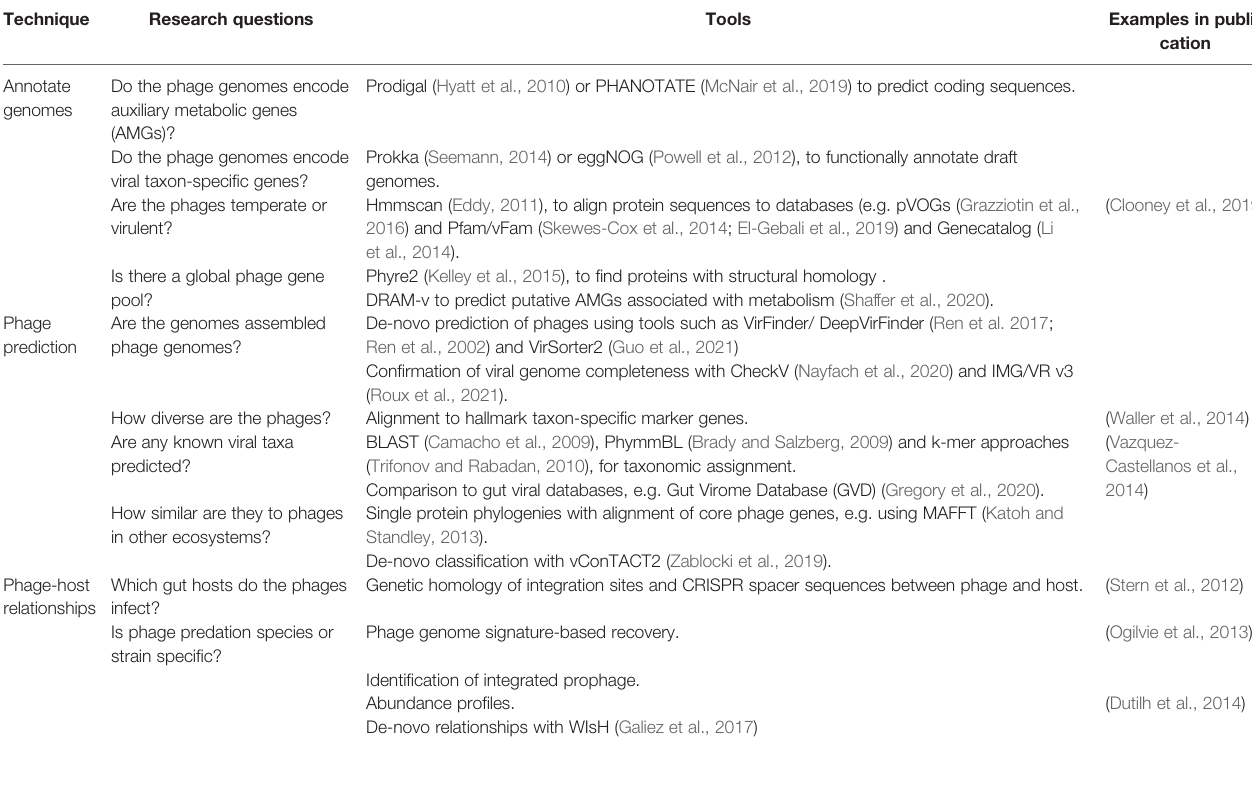
TABLE 3 | Bioinformatic tools used to study the gut phageome, including techniques, research questions they may address and name of the